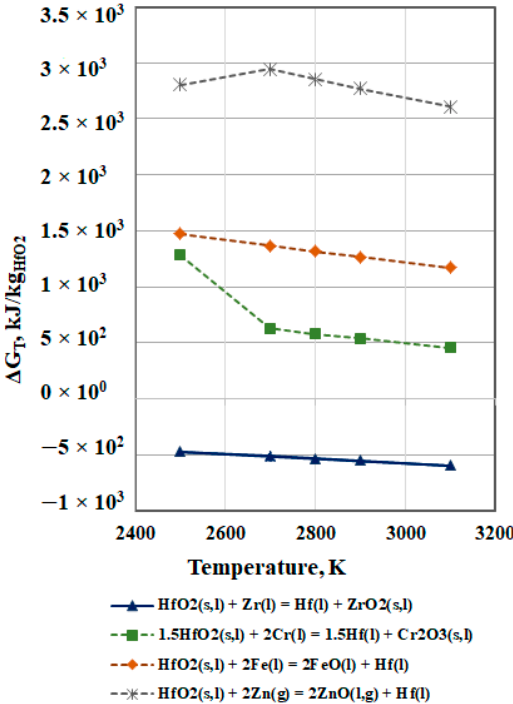
Figure 5. Free energy for interaction between HfO 2 and metal impurities in vacuum. The analysis of the obtained dependences ( ∆ G T = f(T)) in Figure 5 shows that in vac- uum conditions, only the reaction HfO 2 (s,l) + Zr(l) = Hf(l) + ZrO 2 (s,l) is thermodynamically probable. As the temperature increases, the probability for this process slightly increases. The positive values of the Gibbs energy of the chemical reactions between HfO 2 (s,l) and other impurities such as chromium, iron, and zinc indicate that they are thermodynamically impossible